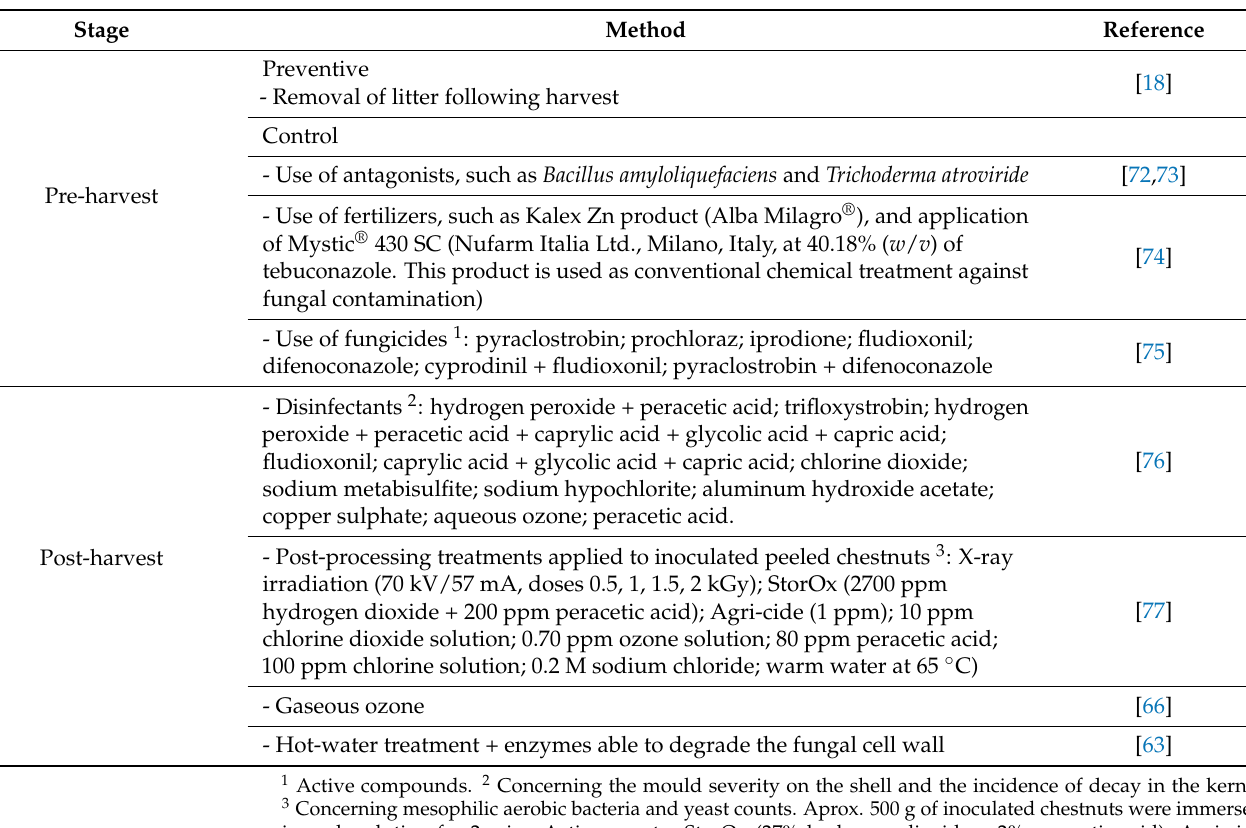
Table 3. Methods to prevent and control G. smithogilvyi during pre-harvest and